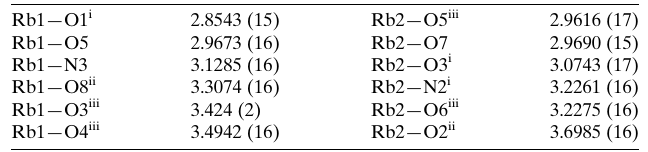
Table 1 Selected bond lengths (A˚ ) for ( 1 ).